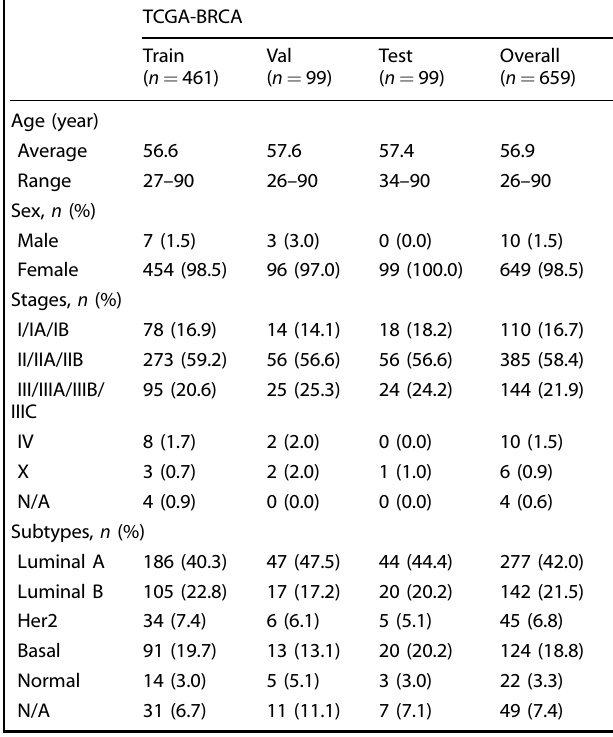
Table 1. Patient characteristics on the 659 cases from TCGA-BRCA cohort.